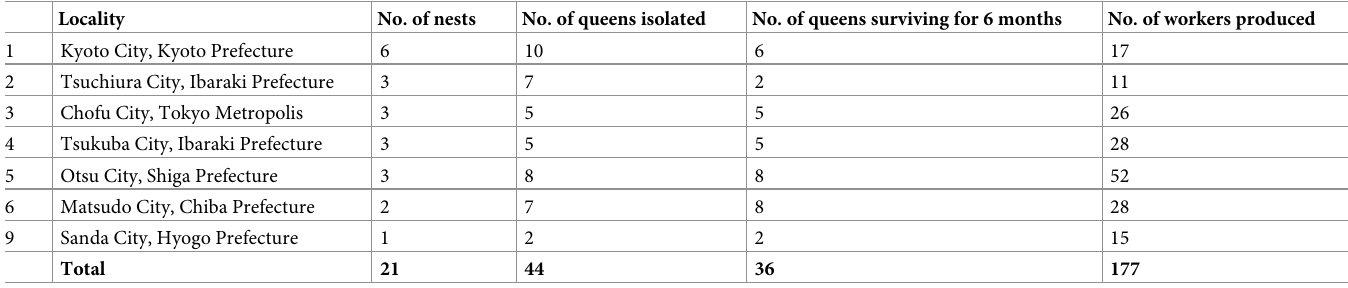
Table 3. Thelytokous worker production in the rearing experiment.